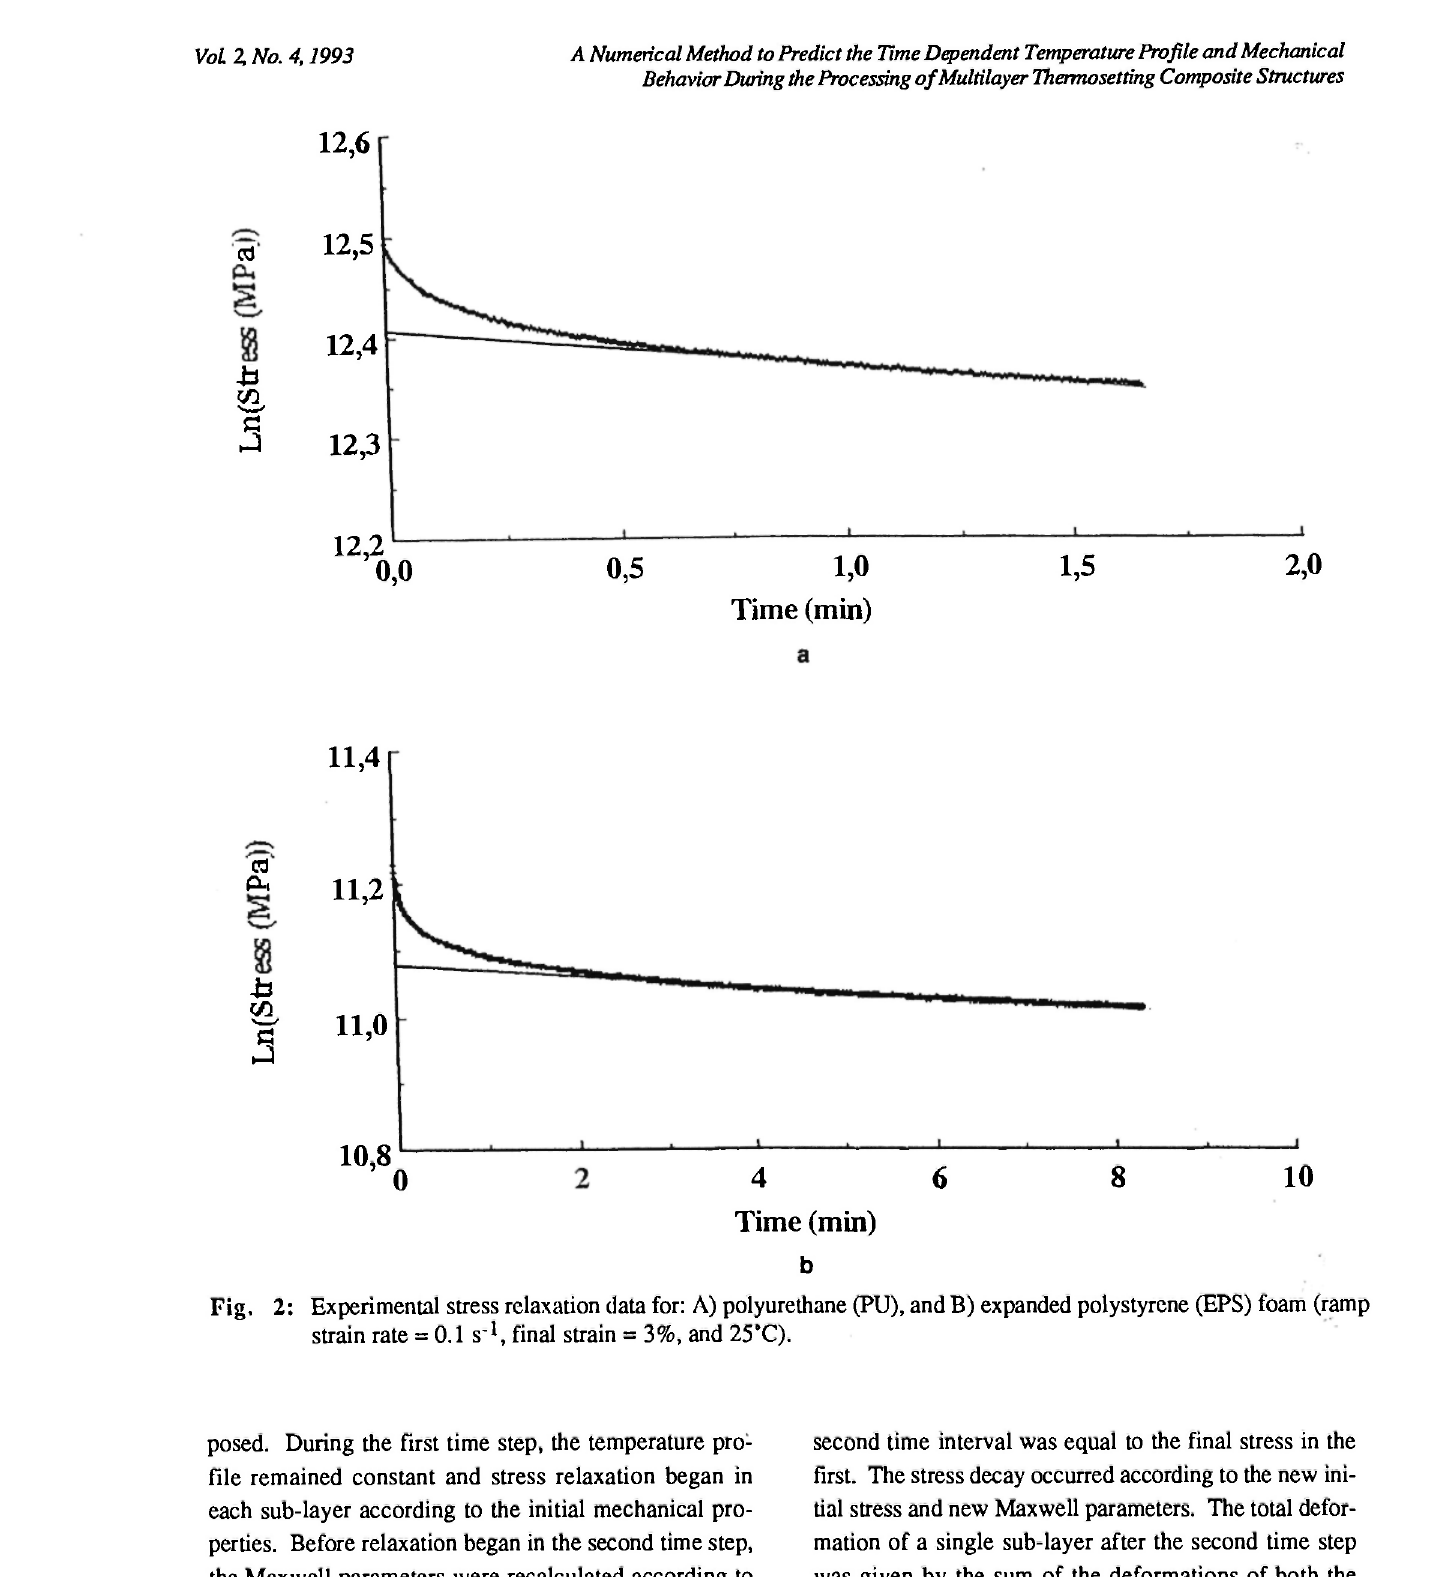
Fig. 2: Experimental stress relaxation data for: Α) polyurethane (PU), and B) expanded polystyrene (EPS) foam (ramp strain rate = 0.1 s" 1 , final strain = 3%, and